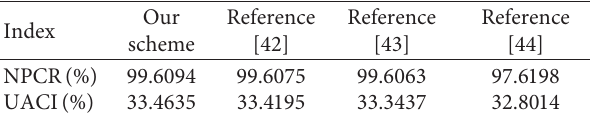
Table 12: NPCR and